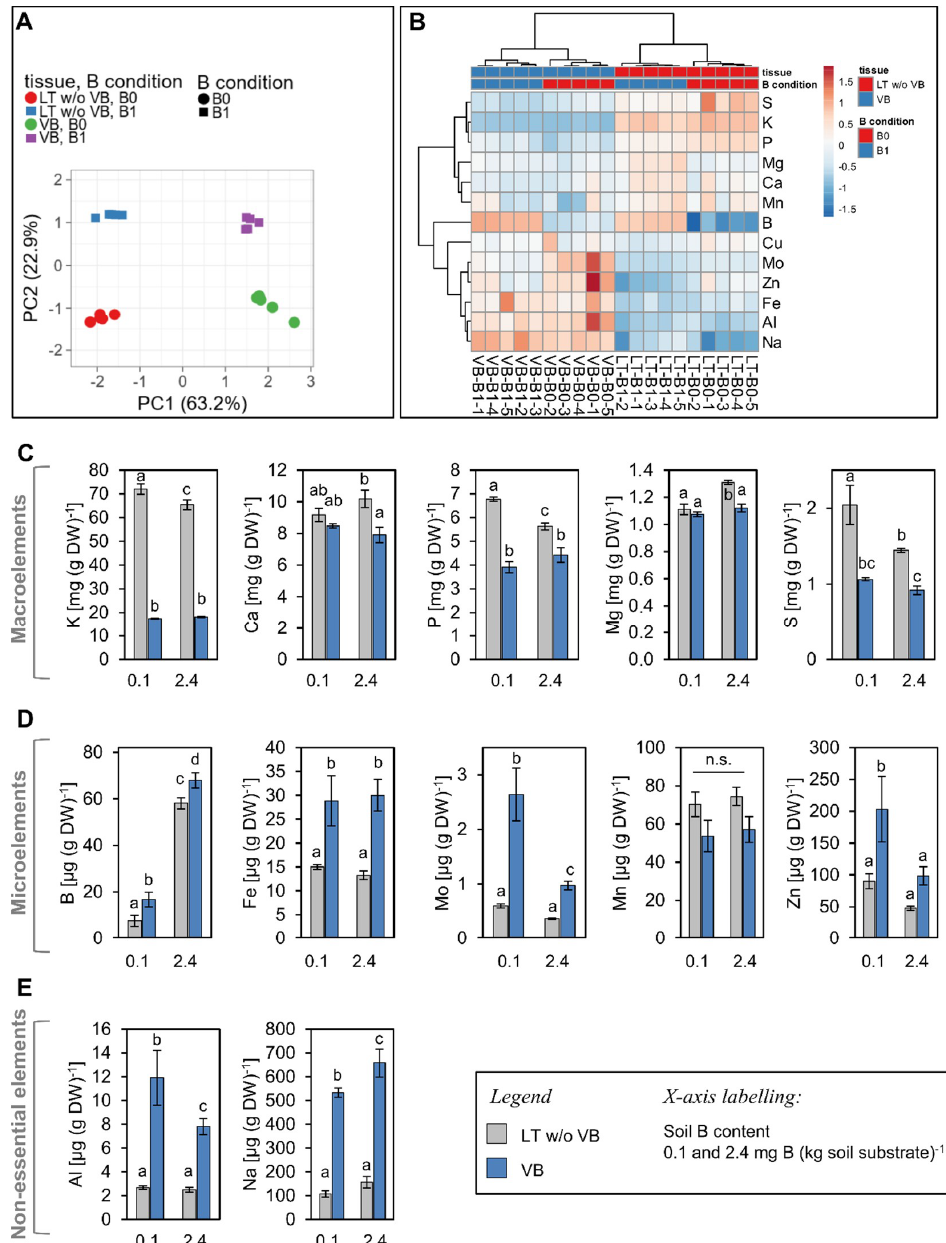
Figure 4. Concentrations of nutrients and mineral elements in vascular bundles (VB) and leaf tissue without vascular bundles (LT w/o VB) from P. major plants grown under 0.1 (B0) or 2.4 mg (B1) B (kg soil substrate) −1 . ( A ) Principal component (PC) analysis (PC1 versus PC2) of the different tissues and B conditions based on elemental concentrations. Original values are ln(x + 1)-transformed. Pareto scaling was applied to values. Information about PCA loadings and explained variances of PCs can be found in Supplemental Figure S1 ( B ) Hierarchical cluster analysis of nutrient distributions determined in five pools à six plants (1–5). Results are represented by a dendrogram and heatmap showing relationships of nutrients and samples. Both rows and columns are clustered using correlation distance and average linkage. ( C ) Concentrations of macroelements, ( D ) concentrations of microelements, ( E ) concentrations of non-essential elements. ( C–E ) Bars represent mean values of indicated element concentration ± SD, n = 5 (DW = dry weight). Error bar labels with different letters indicate significant differences at p < 0.05 between treatments and tissues according to One-way ANOVA with post-hoc Tukey test. n.s. = no significant differences ( p > 0.05).